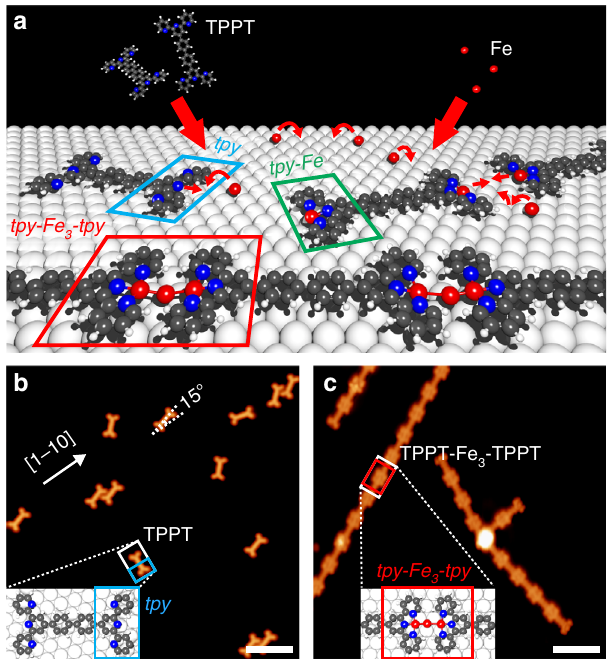
Fig. 1 Self-assembly of 1D metal-organic nanostructures on a noble metal surface. a Schematic of the bottom-up synthesis of metal-organic nanochains (MOCs) via on-surface terpyridine ( tpy ) – iron (Fe) coordination. TPPT molecules and Fe adatoms were sequentially deposited from the gas phase onto the Ag(111) surface held at room temperature. b STM image of TPPT molecules adsorbed on Ag(111) ( I t = 5 pA, V b = 20 mV). c STM image of MOCs resulting from the on-surface metal – ligand coordination ( I t = 25 pA, V b = 20 mV). The STM tip was functionalised by picking up a single carbon monoxide molecule (see Methods). Insets: DFT calculated the energetically favourable adsorption geometries of TPPT ( a ) and MOC [( b ); black: carbon; blue: nitrogen; red: iron; grey: silver]. Scale bars: 5